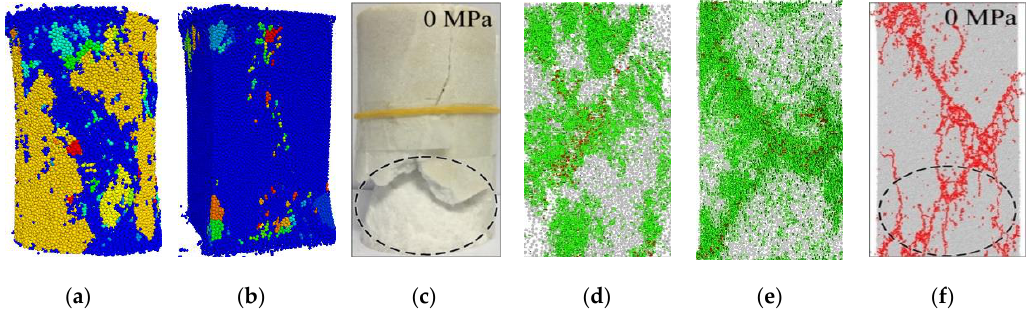
Figure 4. Comparison of ultimate failure patterns obtained from ( a – d ) numerical simulations and ( e ), ( f ) previous experimental observations [39,65]. Table 1. Microscopic mechanical parameters of marbles in the discrete element